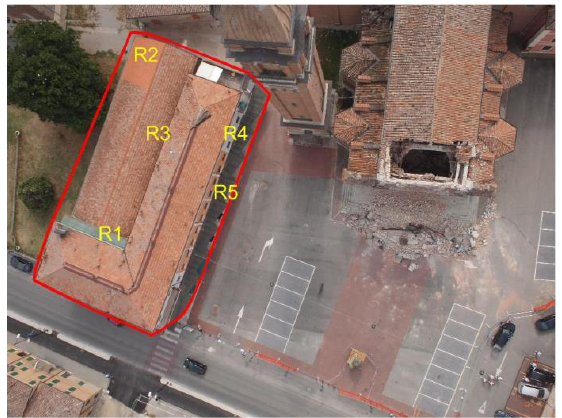
Figure 3. Building delineated in image and annotated regions (R1 –R5) are used for feature significance analysis as described in section 3.1.2